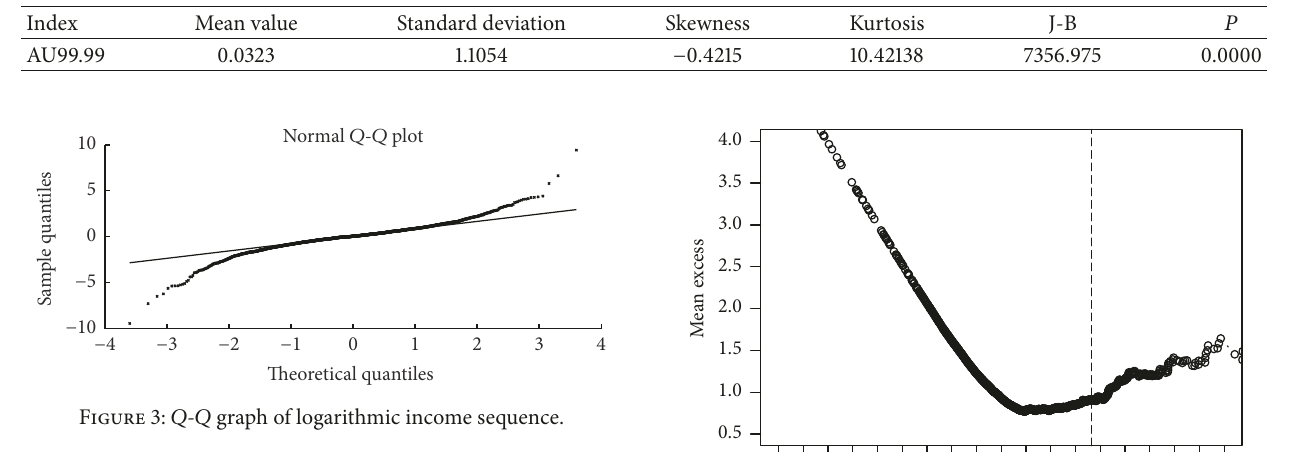
Table 1: The statistical characteristics of the logarithmic yield of gold price.